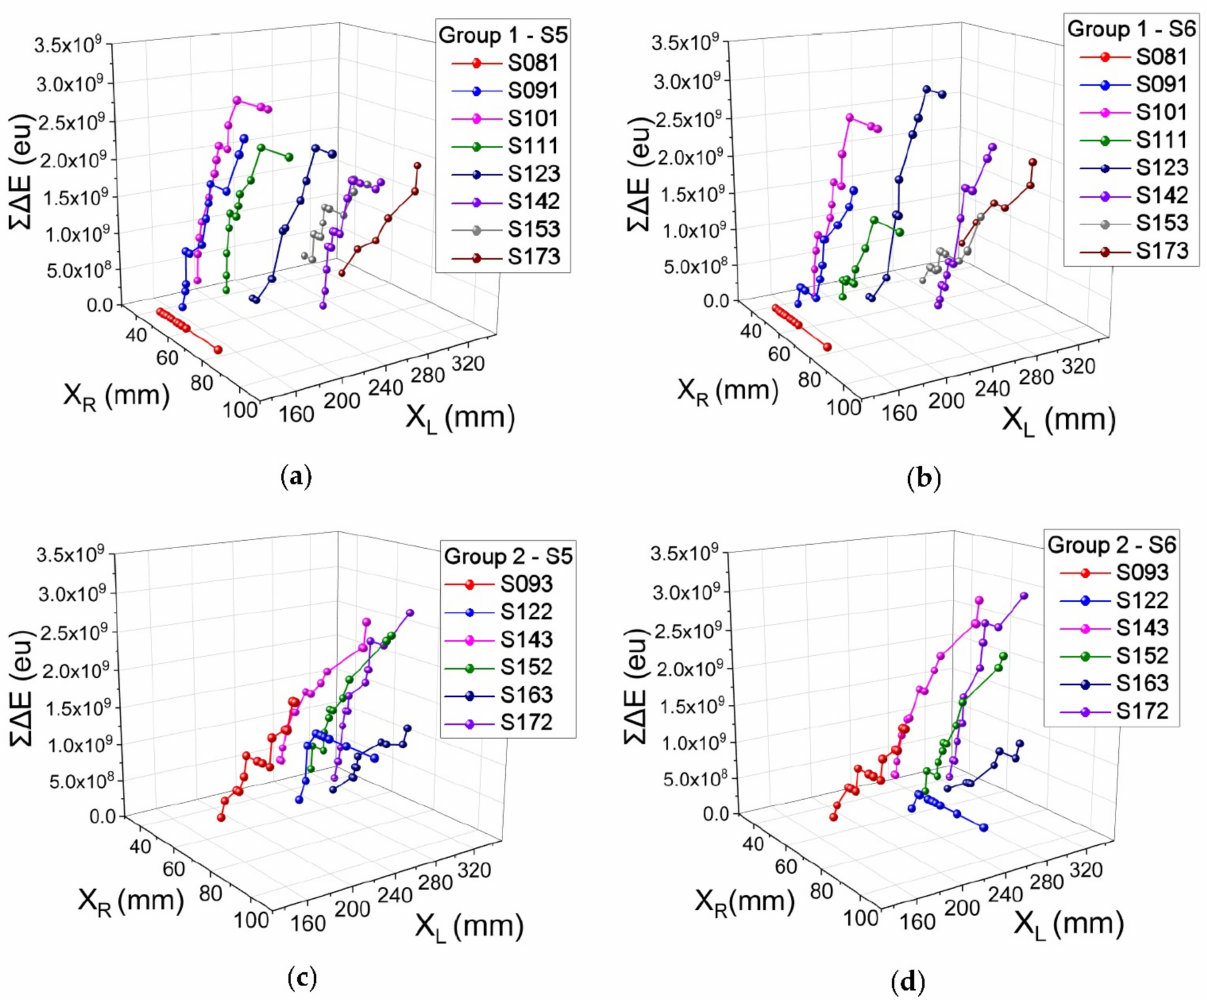
Figure 10. Three-dimensional graph: x-axis—radial position X R (mm); y-axis—longitudinal position X L (mm); z-axis— cumulative sum of the energy, i.e., Σ∆ E (eu). ( a ) Group 1, S5; ( b ) Group 1, S6; ( c ) Group 2, S5; and ( d ) Group 2,